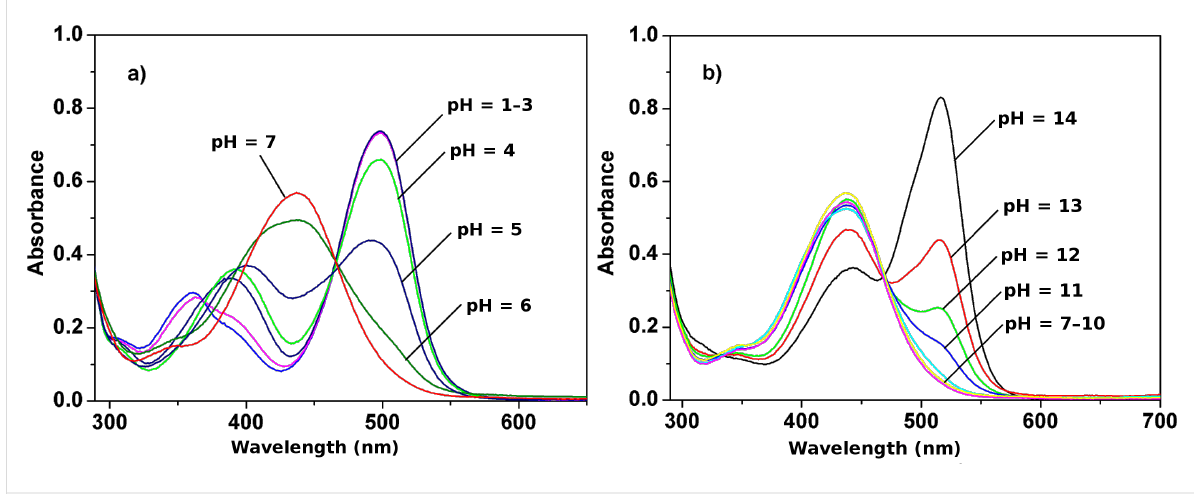
Figure 3: pH-dependent changes in UV–vis spectra of 1 (5.0 × 10 − 5 M) in CH 3 CN/H 2 O (1:1, v/v) at (a) pH = 1–7, and (b) pH = 7–14.